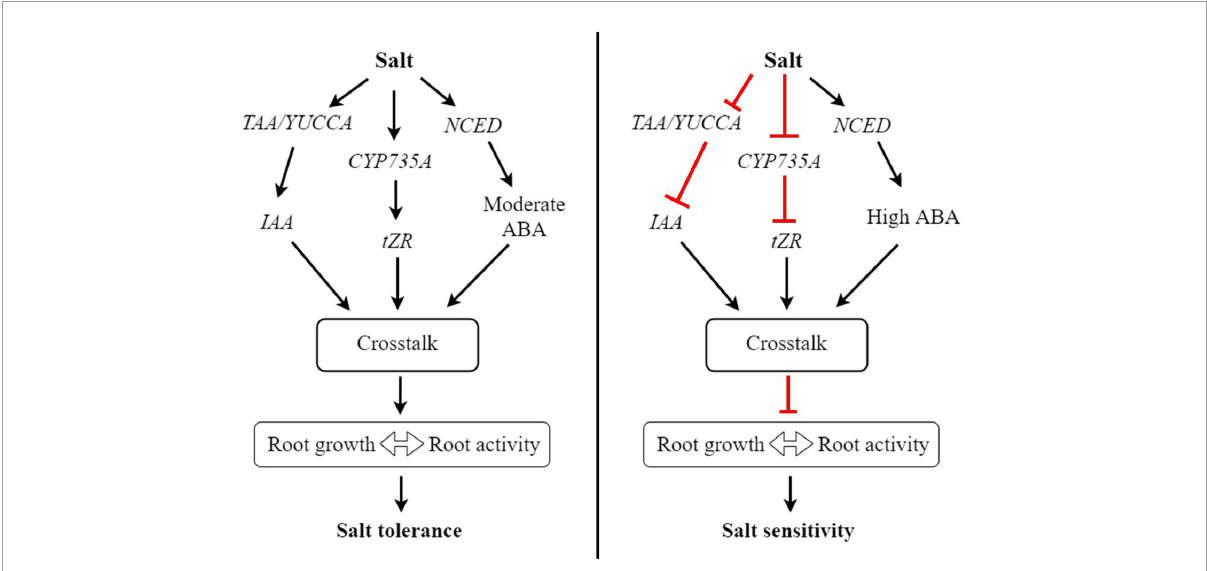
FIGURE9 A proposed working model of how hormonal reprogramming and crosstalk are involved in root growth and salt tolerance in bermudagrass. In roots, salt stress induces the expression of TAA/YUCC, CYP735A, and NCED genes involved in auxin, cytokinin, and ABA biosynthesis, respectively. The activation of these genes increases the accumulation of respective hormones in roots. Subsequently, these hormones could work together through hormonal crosstalk and increase root growth and root activity, ultimately improving salt tolerance in bermudagrass. In contrast, salt stress inhibits the expression of TAA/YUCC and CYP735A genes, leading to reduced auxin and cytokinin levels in roots, respectively. On the other hand, salt stress strongly induces the expression of NCED , leading to the accumulation of a high level of ABA in roots. The reduced levels of auxin and cytokinin and high ABA level undergo hormonal crosstalk in roots and inhibit root growth, thus diminishing root activity and increasing salt sensitivity in